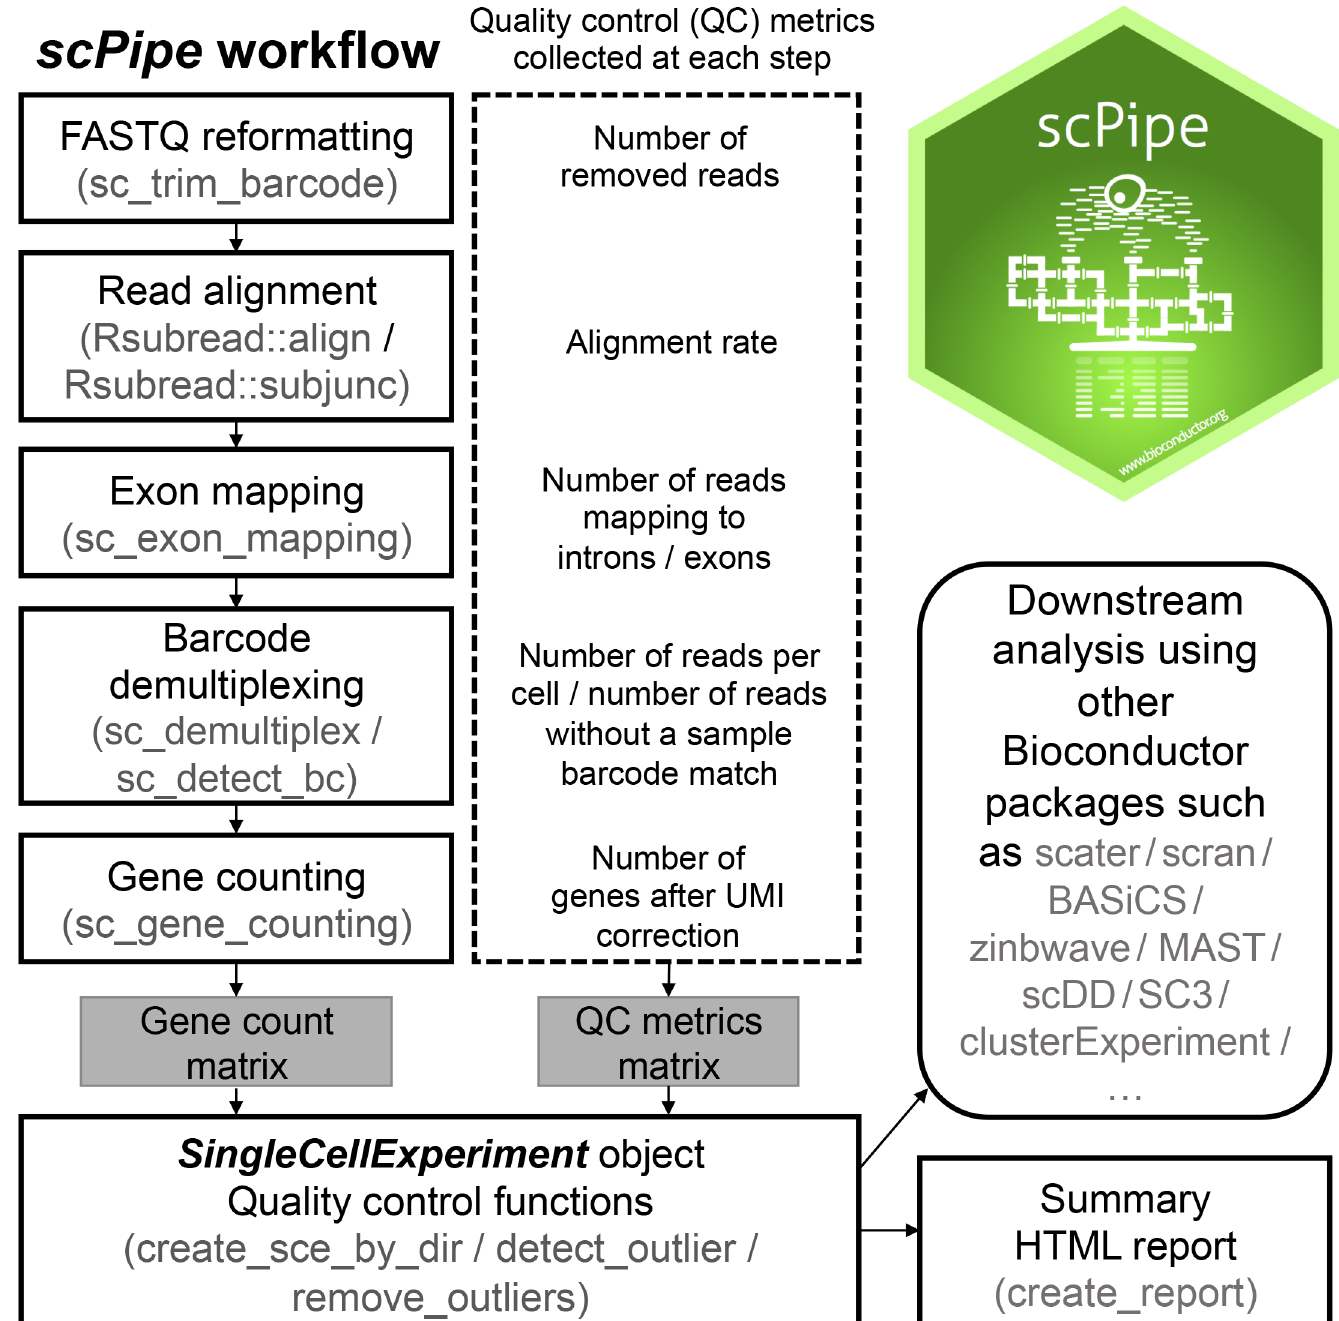
Fig 1. The scPipe workflow. scPipe is an R/Bioconductor package that uses functionality from a number of other packages, including Rsubread to align reads to a reference genome (although in practice any aligner that produces BAM files can be used for read alignment) and SingleCellExperiment to organise the counts and sample annotation information. The major steps in the preprocessing pipeline of scPipe are shown along with the quality control (QC) statistics collected at each stage. The final output of this process is a matrix of counts and QC metrics for use in downstream analysis and an HTML report that summarises the analysis. The resulting SingleCellExperiment object can be used as input to other Bioconductor packages to perform further downstream analysis. scPipe logo created by Roberto Bonelli published under a CC0 1.0 license (https://github.com/Bioconductor/BiocStickers/blob/master/scPipe/README.md).